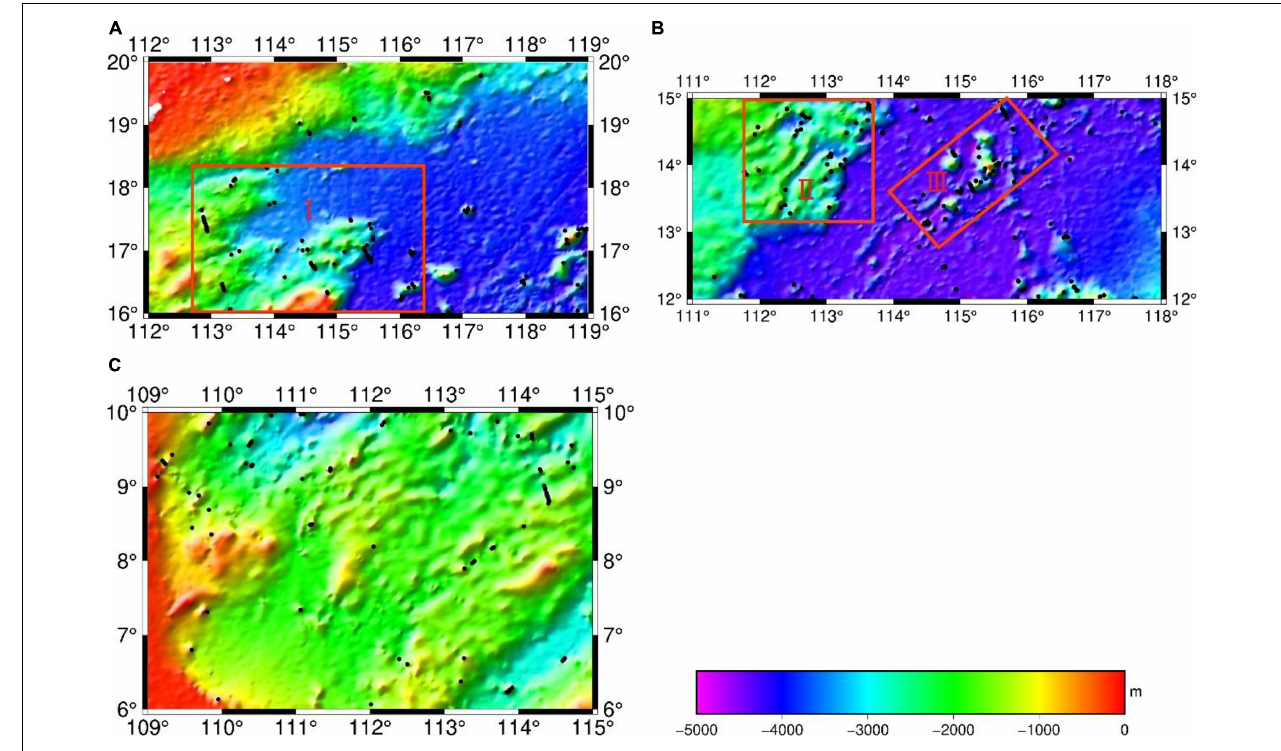
FIGURE 7 | Distribution of differences between NCEI bathymetry and GGM bathymetry in the test areas. (A) Error points distributionin test area A. (B) Error points distributionin test area B. (C) Error points distributionin test area C. The black spot represents the distribution of depth errors greater than 250 m. the red rectangles represents the area with large error, and the background map is GGM bathymetry prediction.